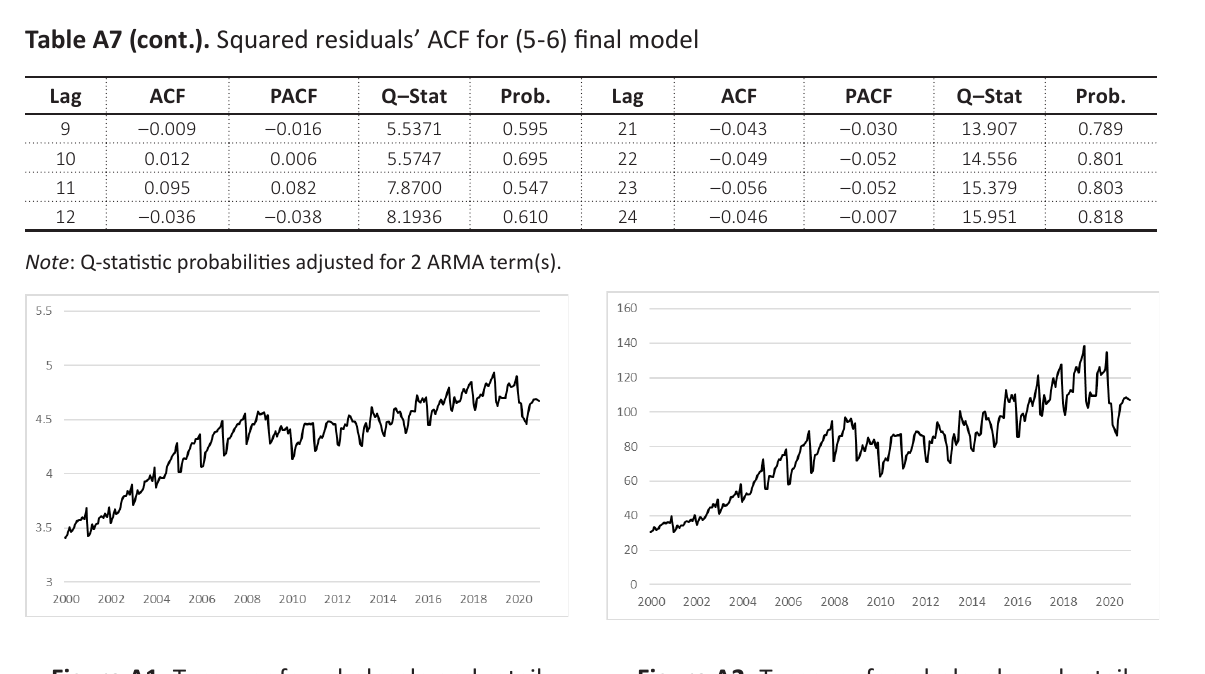
Figure A1. Turnover for wholesale and retail trade and repair of motor vehicles and motorcycles in Bulgaria (Indices, 2015 = 100%)